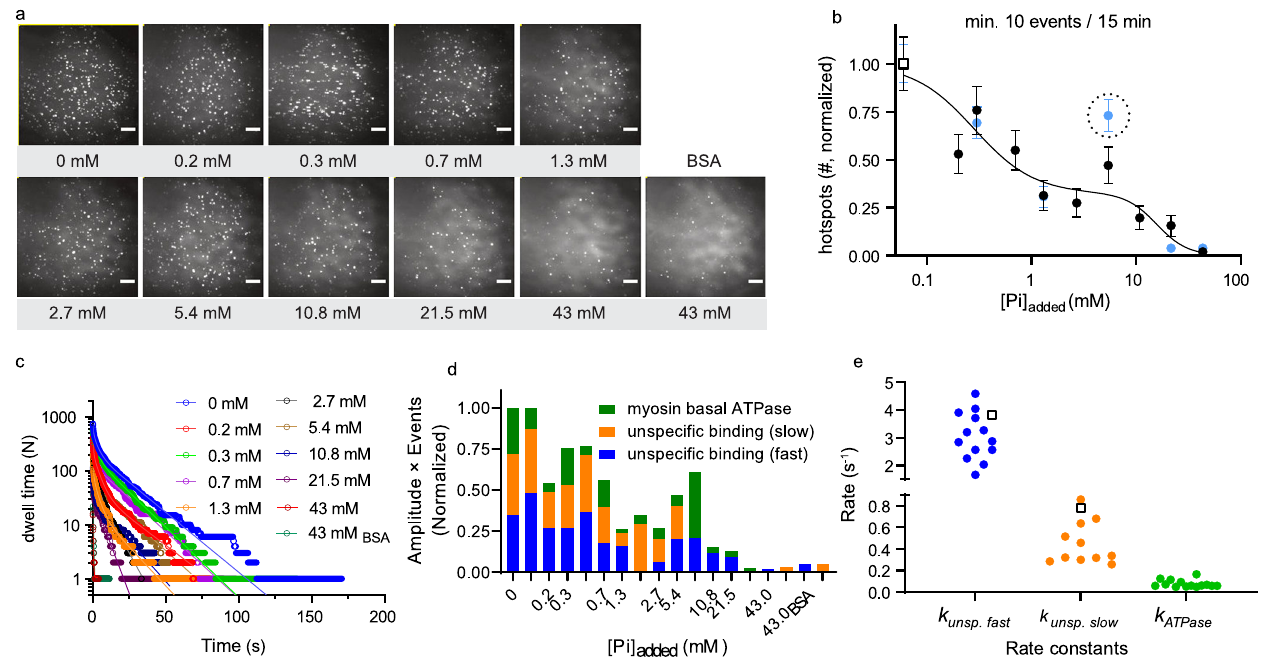
Fig. 2 | Single-molecule Alexa647-ATP binding to HMM with increasing [Pi]. a Time-averaged Alexa-ATP binding event is represented as fl uorescence projec- tions(standarddeviationfunctioninFiji[ImageJ])of15minvideos(50msexposure time/frame; Movie S1) under increasing added [Pi] (mM). HMM incubation at 34.3pM.Incontrolexperiments,thecoverslipswerecoatedonlywithbovineserum albumin (BSA). Scale bar, 5 µ m. b Hotspot numbers decrease by increasing added [Pi]. The experiments were performed on two different occasions (series 1, black; series 2, light blue). The numbers (N, point estimates in counting process) were normalized to the number of hotspots (series 1=51 and series 2=26) in control experiments(opensquare)withoutadded[Pi],butwithestimatedbackground[Pi] ≤ 0.06mM. Error bars represent standard deviation (SD) in a Poisson process, estimatedas √ N.Thecurved line added toguidetheeye representsa fi ttothesum of two Hills equations 39 with K d1 ~0.3mM and K d2 ~16mM. Experiment with HMM